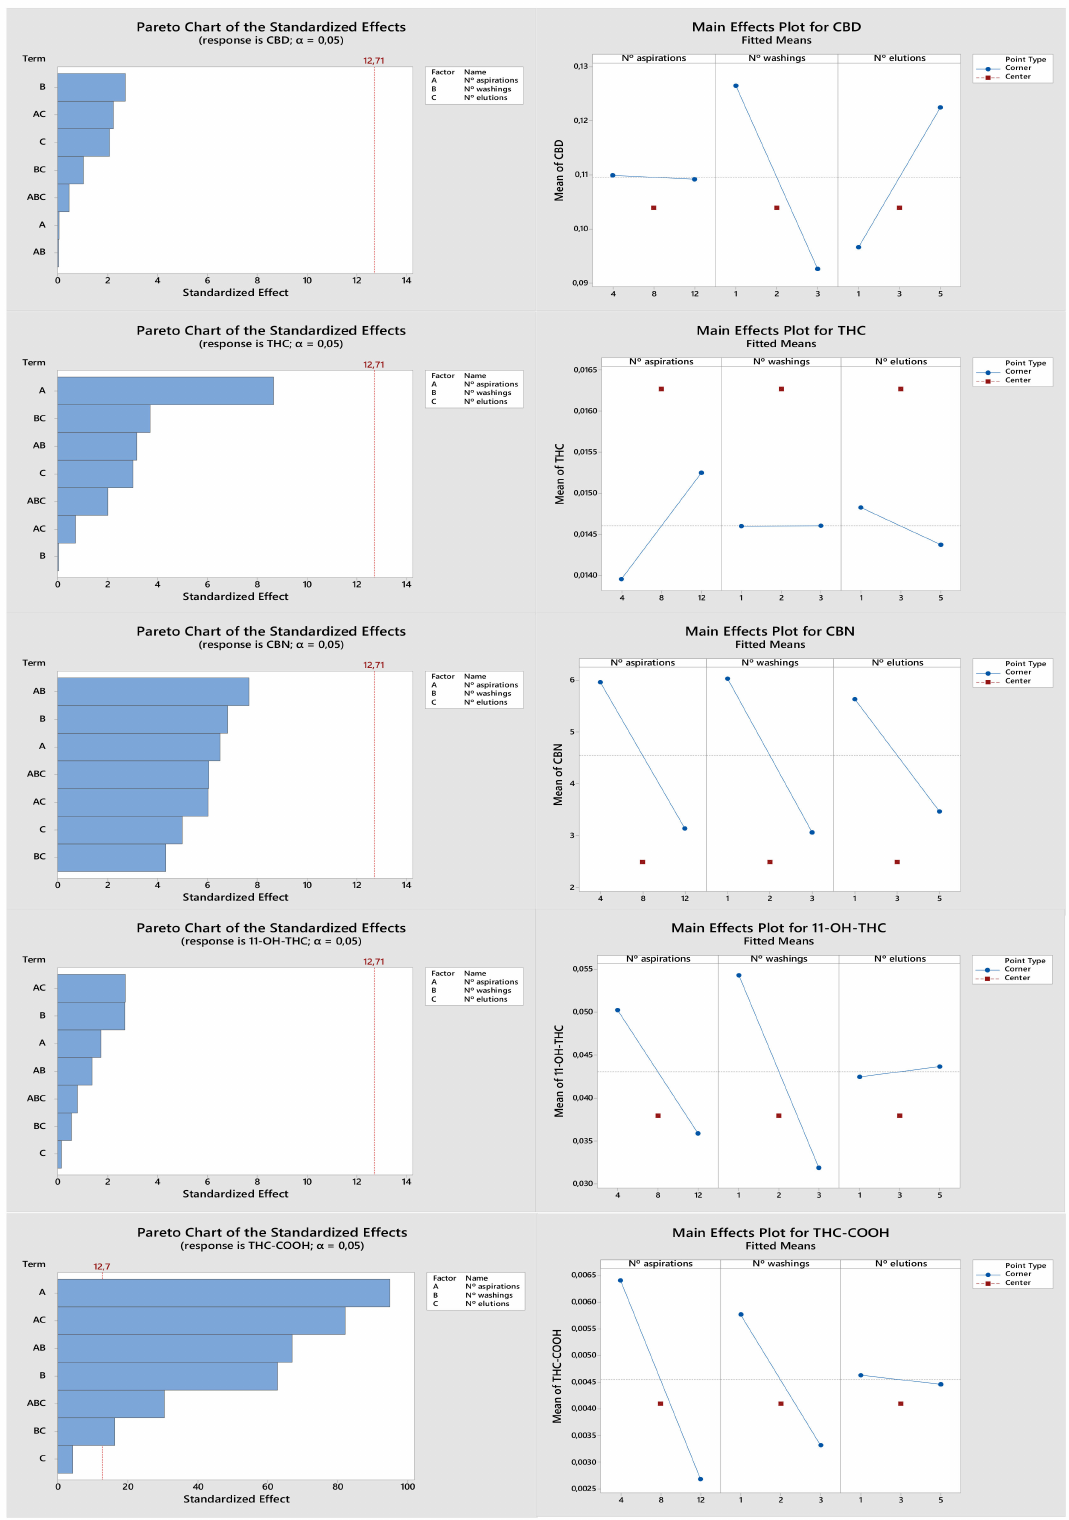
Figure 1. Graphical representation of DOE optimization for CBD, THC, CBN, 11-OH-THC, and